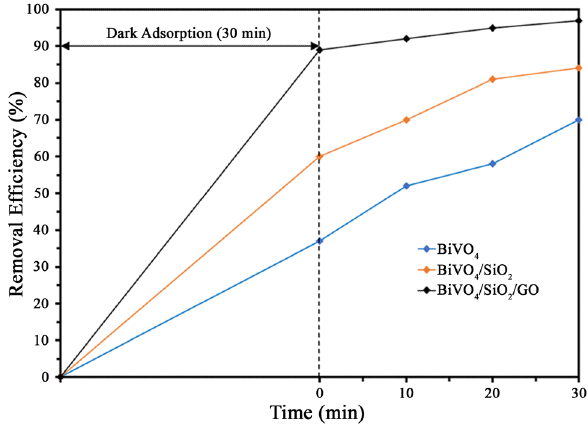
Figure 3. Photodegradation of MB over BiVO 4 , BiVO 4 /SiO 2 , BiVO 4 /SiO 2 /GO.